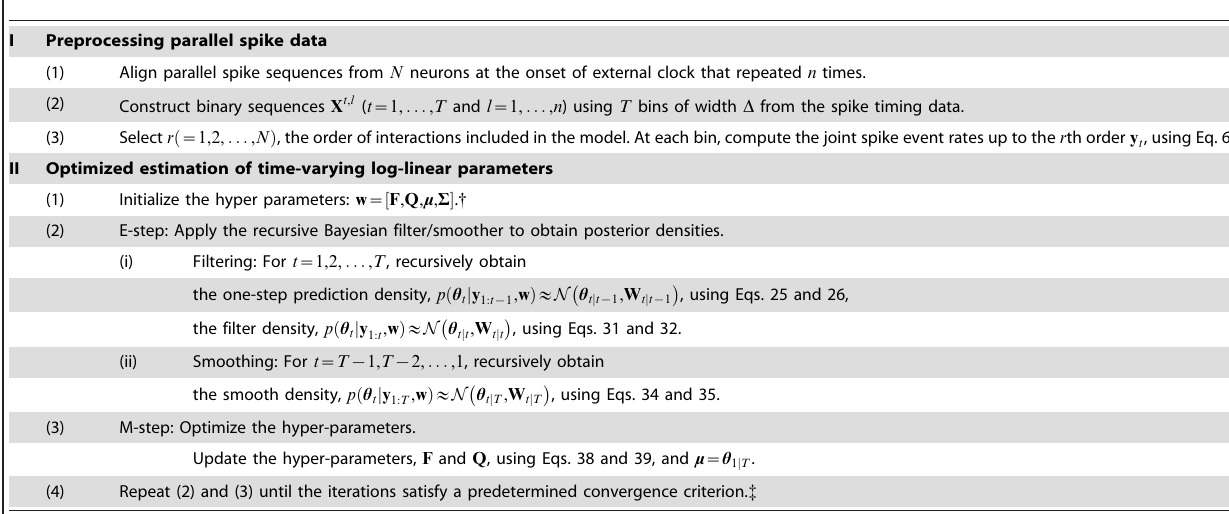
Table 1. Method for estimating dynamic spike